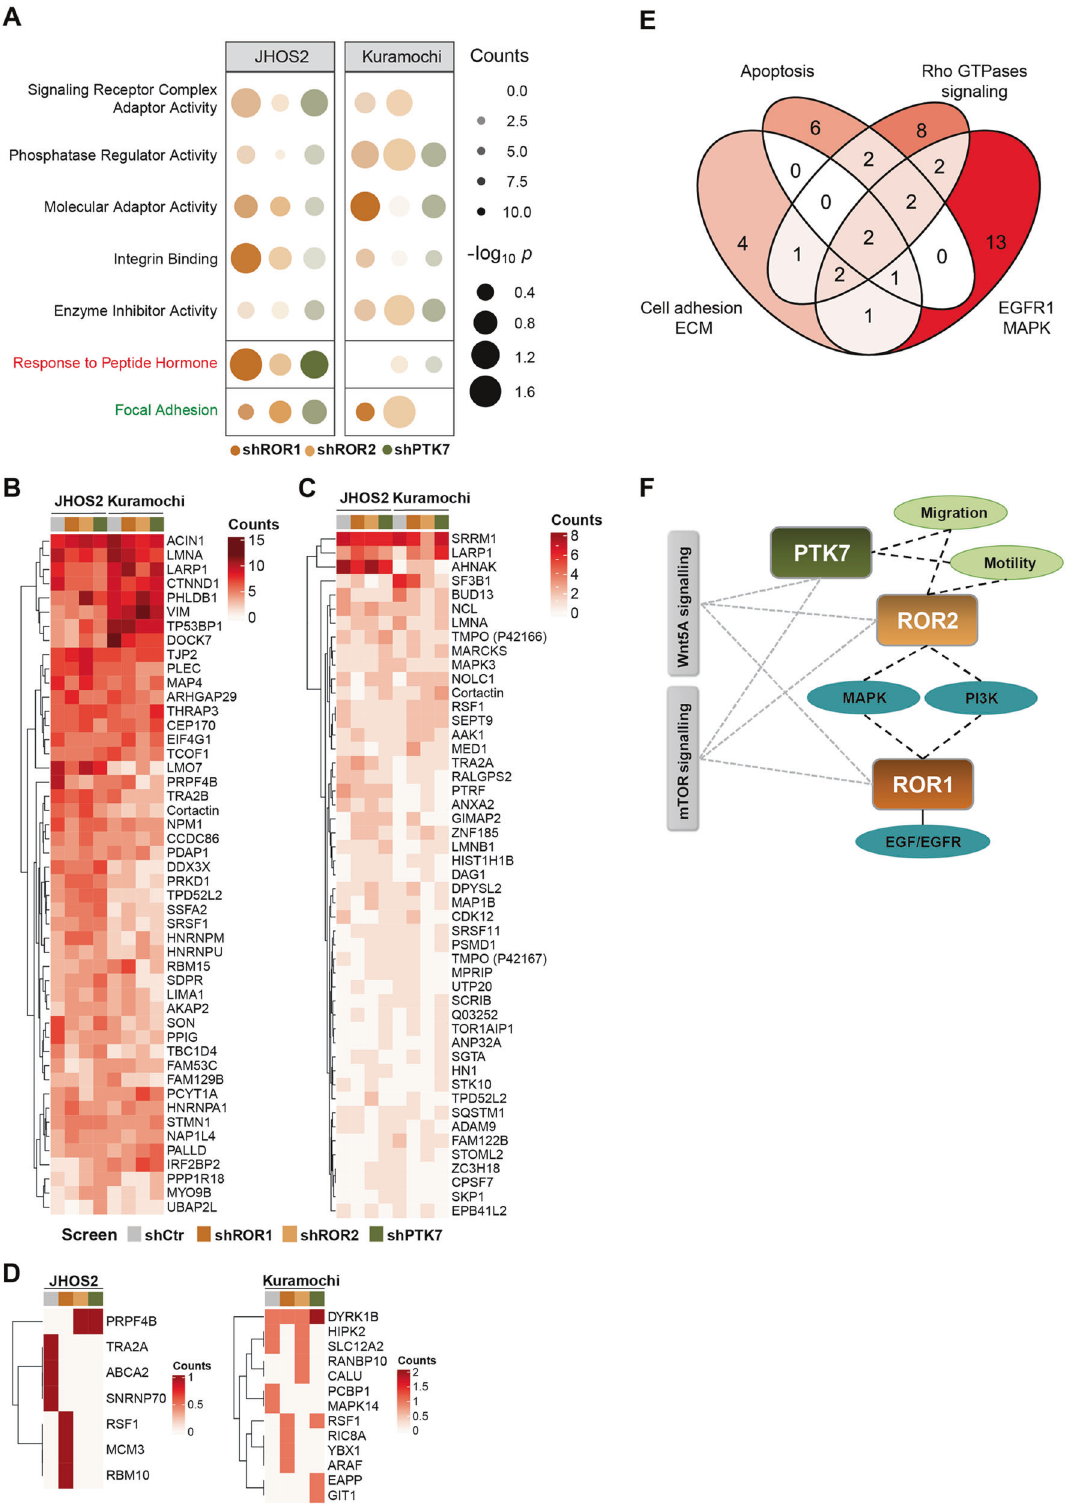
Fig. 4 Phosphoproteomics uncovers speci fi c signaling dynamics associated with PTK7, ROR1, and ROR2 expression in OC cells. A Commonly identi fi ed molecular functions (black), biological processes (red) and cellular components (green) following phosphoproteomics and functional enrichment analysis of shROR1, shROR2, and shPTK7 samples compared to shCtr samples in both JHOS2 and Kuramochi cell lines. B – D Heatmaps of dysregulated phosphoproteins in terms of phospho-serine ( B ), -threonine ( C ), and -tyrosine ( D ) in shRNA JHOS2 and Kuramochi cell lines. For a better visualization, AHNAK and TNKS1PB1 were left out from the heatmap B , whereas SRRM2 was left out from the heatmap C , but they were included in all analyses. E Venn diagram depicting the top four dysregulated pathways among the phosphoproteins identi fi ed in B – D . F Schematic representation of the terms associated with PTK7, ROR1, and ROR2, based on GO functional enrichment analysis. The terms speci fi c to one receptor are linked by solid lines, whereas terms that are unique to a receptor pair are connected by dashed lines. Cell Death and Disease (2022)